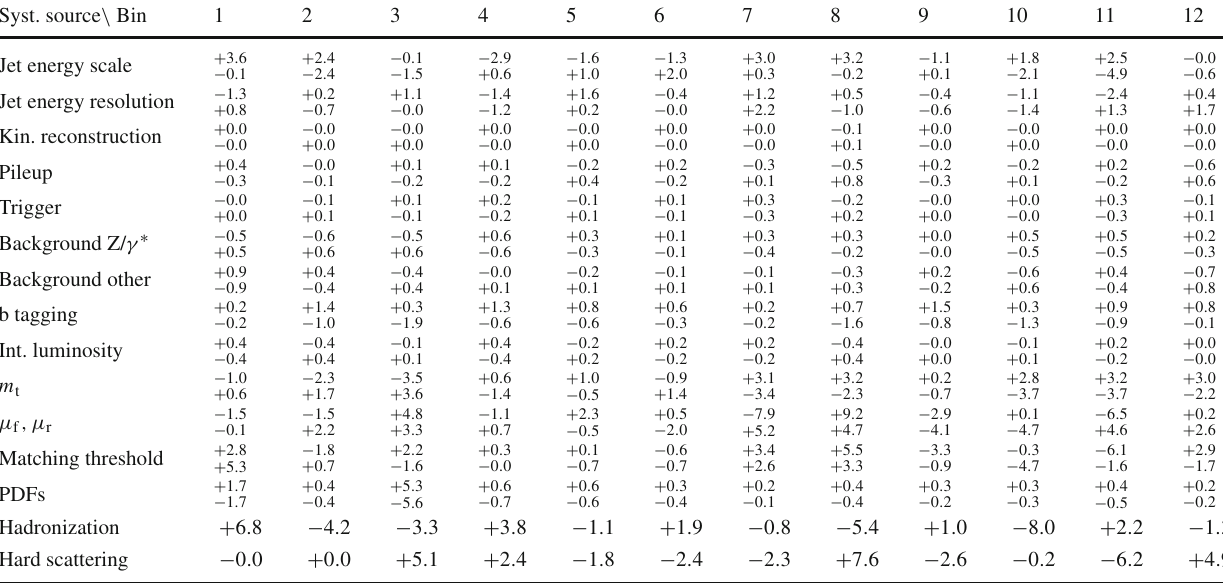
Table 16 Sources and values of the relative systematic uncertainties in percent of the measured normalized tt double-differential cross sections as a function of M ( tt ) and Δη( t , t ) . For bin indices see Table 14 Syst. source \